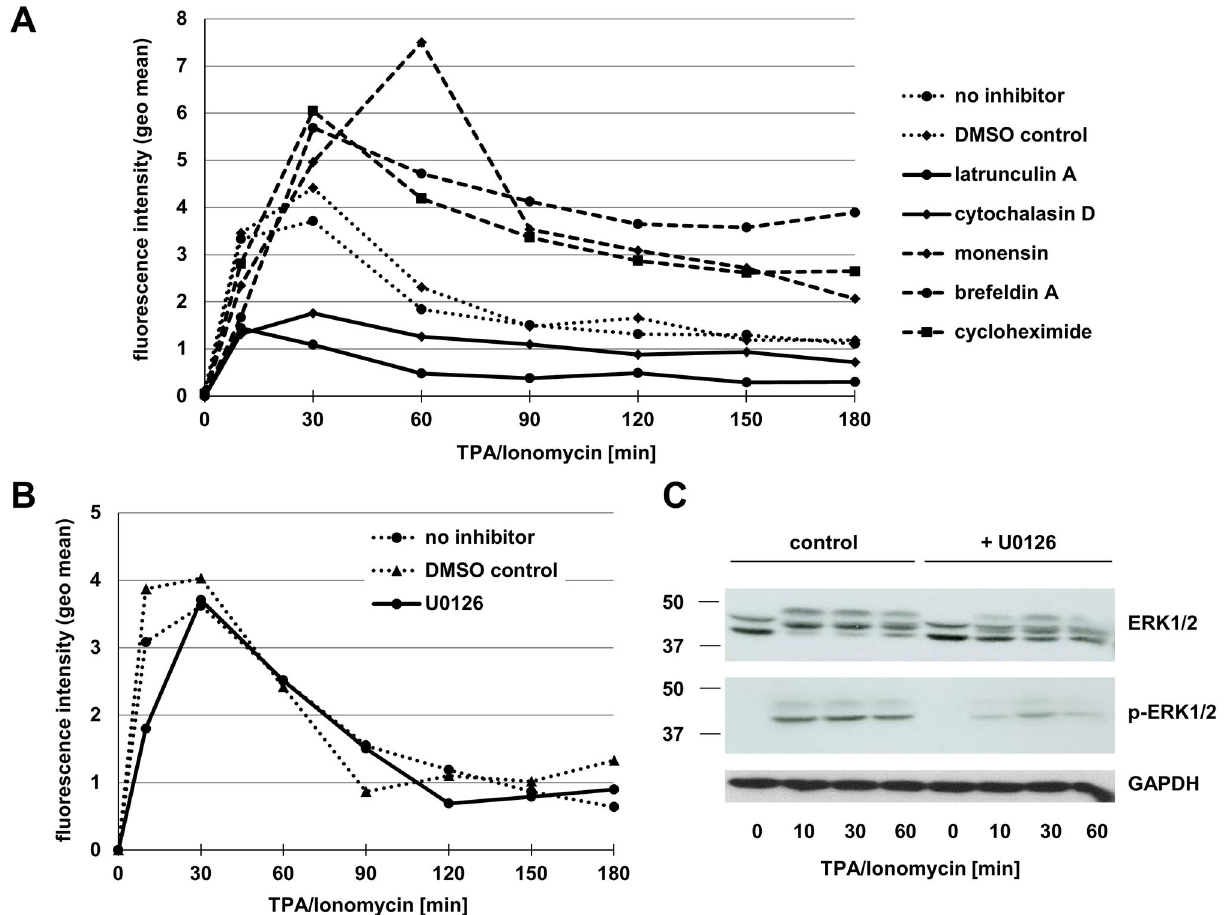
Figure 9. ADAM17 up-regulation can be blocked by inhibitors of actin filament formation. A. PHA blasts were stained for ADAM17 at the indicated time points after stimulation with TPA and Ionomycin with or without pretreatment with the indicated inhibitors for 30 minutes. Only latrunculin A and cytochalasin D markedly reduced the level of inducible ADAM17. B. PHA-activated T cell blasts were stained for ADAM17 at the indicated time points after stimulation with TPA and Ionomycin in the presence or absence of the MEK inhibitor U0126 or DMSO as a solvent control. ERK activation did not influence inducible ADAM17 induction in PHA blasts. C. Western blot for ERK1/2, phospho-ERK1/2 (p-ERK1/2) and GAPDH from T cell blasts. PHA-activated T cell blasts were stimulated for the indicated time periods with TPA and Ionomycin in the presence or absence of U0126 or DMSO as a control. Cells were lysed and proteins separated by SDS-PAGE were analyzed for total ERK protein and ERK phosphorylation. GAPDH staining served as a loading